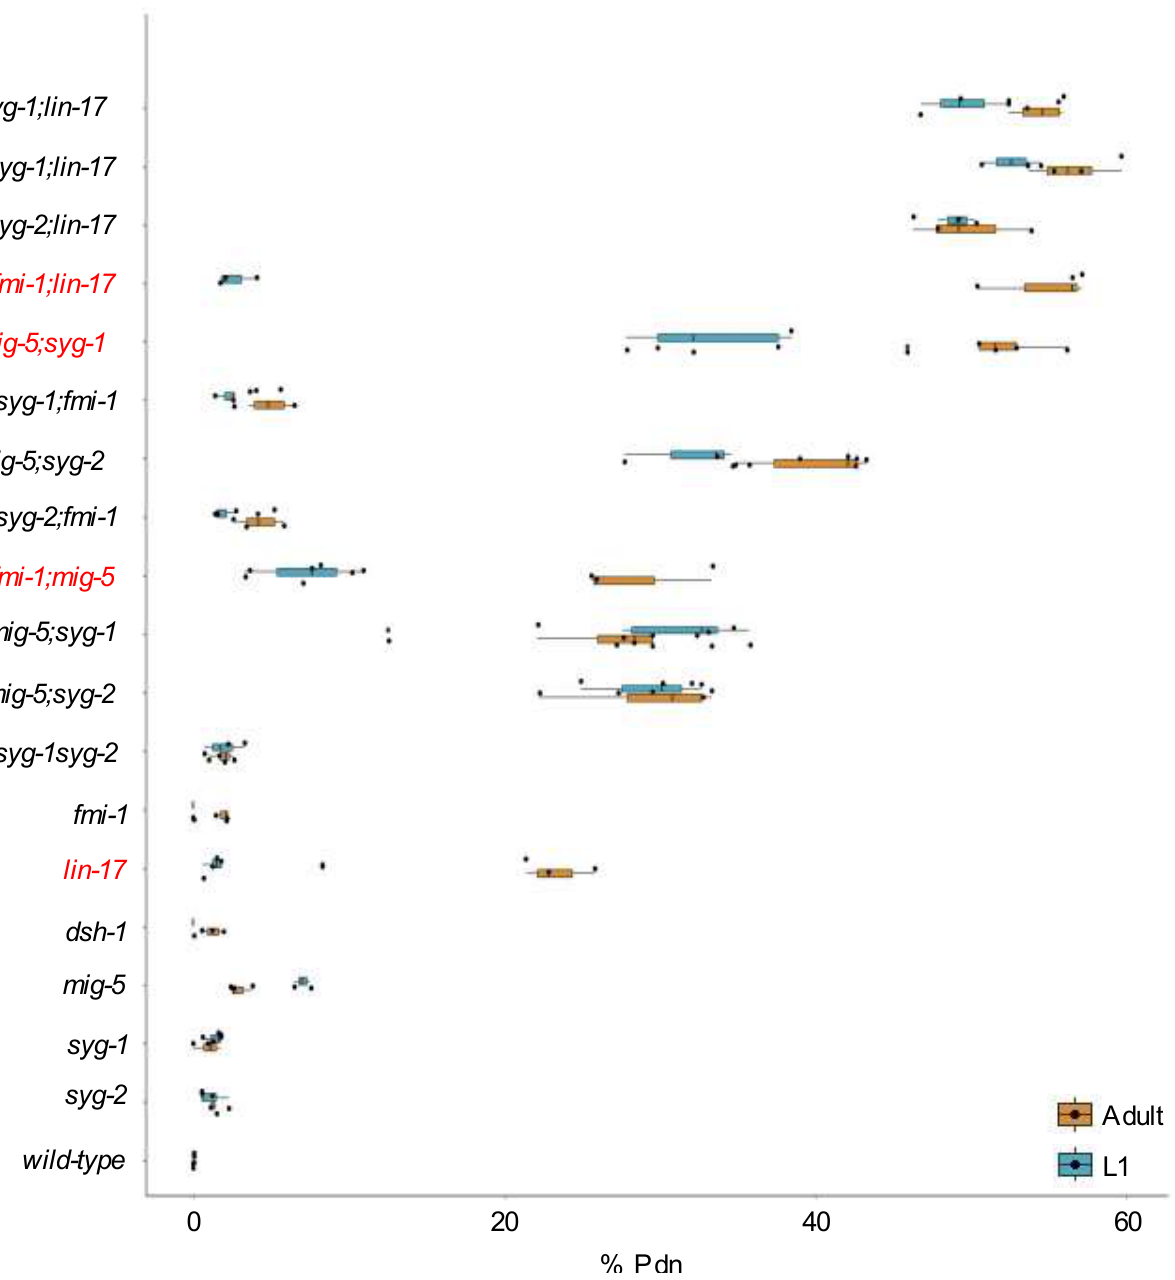
Figure 5. Stage-specific Pdn formation by genotype. A boxplot of the percentage of animals displaying Pdns as L1s (blue boxes) or adults (tan boxes). Genotypes observed to have a significant difference between stages are highlighted (red text).